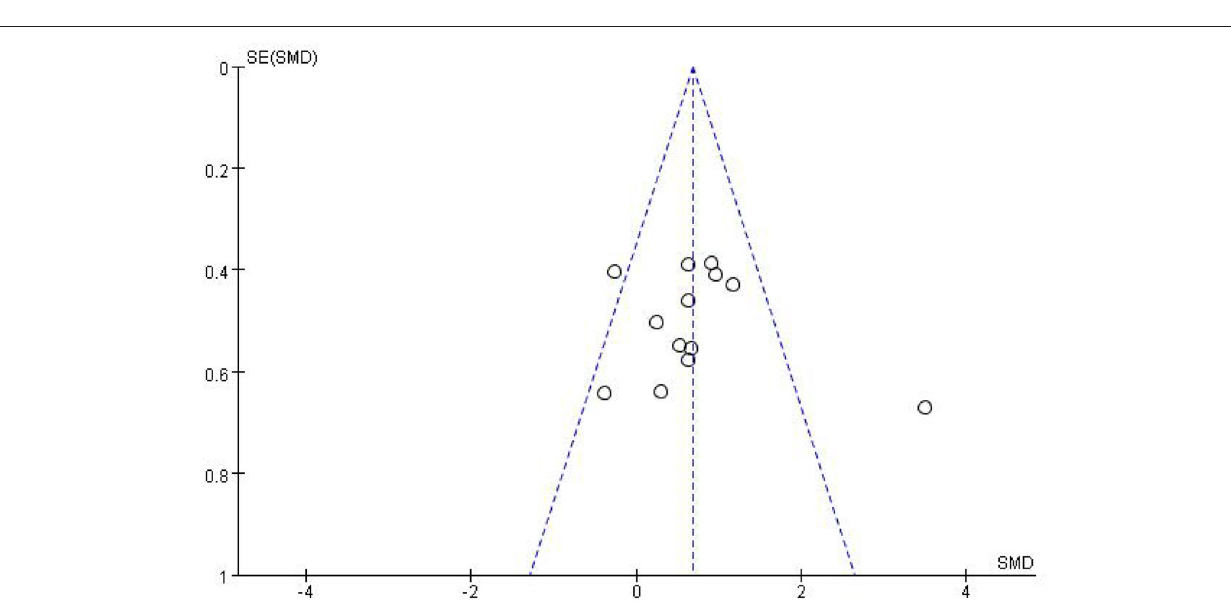
FIGURE 5 | Funnel plot of comparison of the effects of BCI interventions and control interventions on upper limb dysfunction before sensitivity